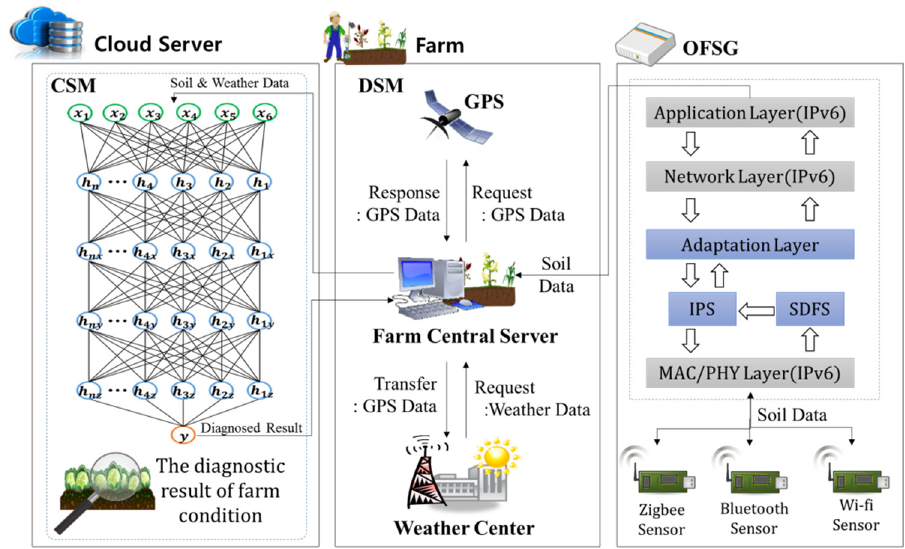
Figure 2. The structure of the total crop-diagnosis platform (TCP). CSM: the crop self-diagnosis module; DSM: the data storage module; OFSG: the optimized farm sensor gateway; IPS: an interconnection protocol sub-module; SDFS: a sensor data fragment sub-module.